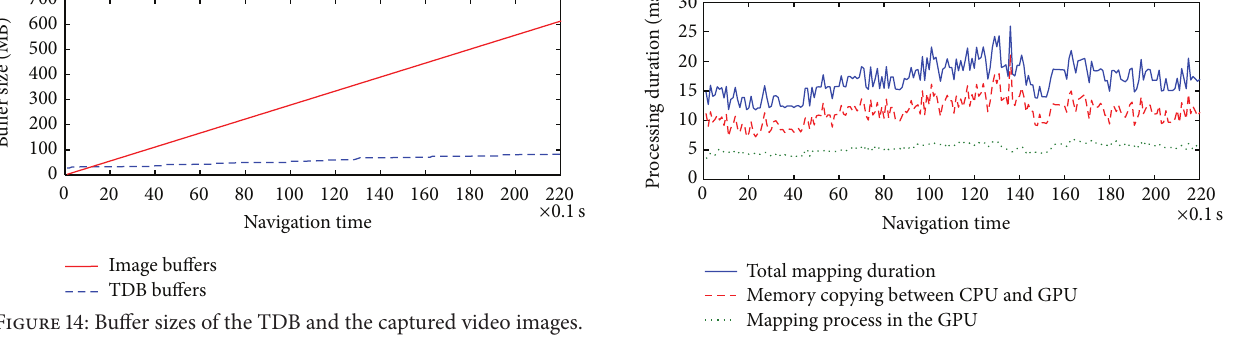
Figure 15: Durations of the mapping process for TDB